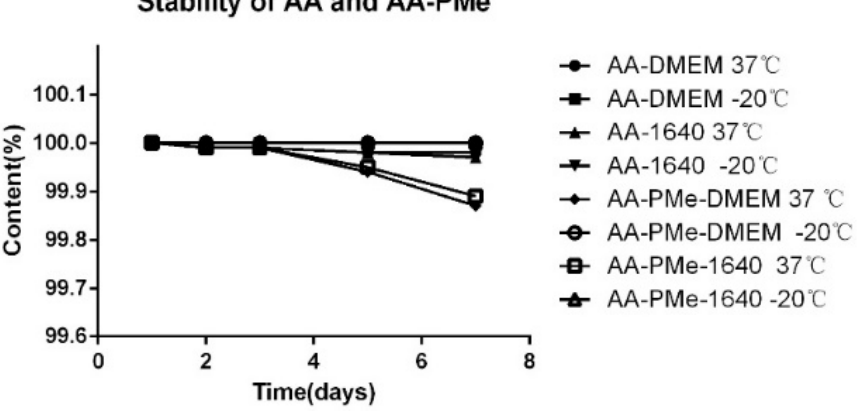
Figure 4. Stability of AA and AA-PMe ( 10 ) under different